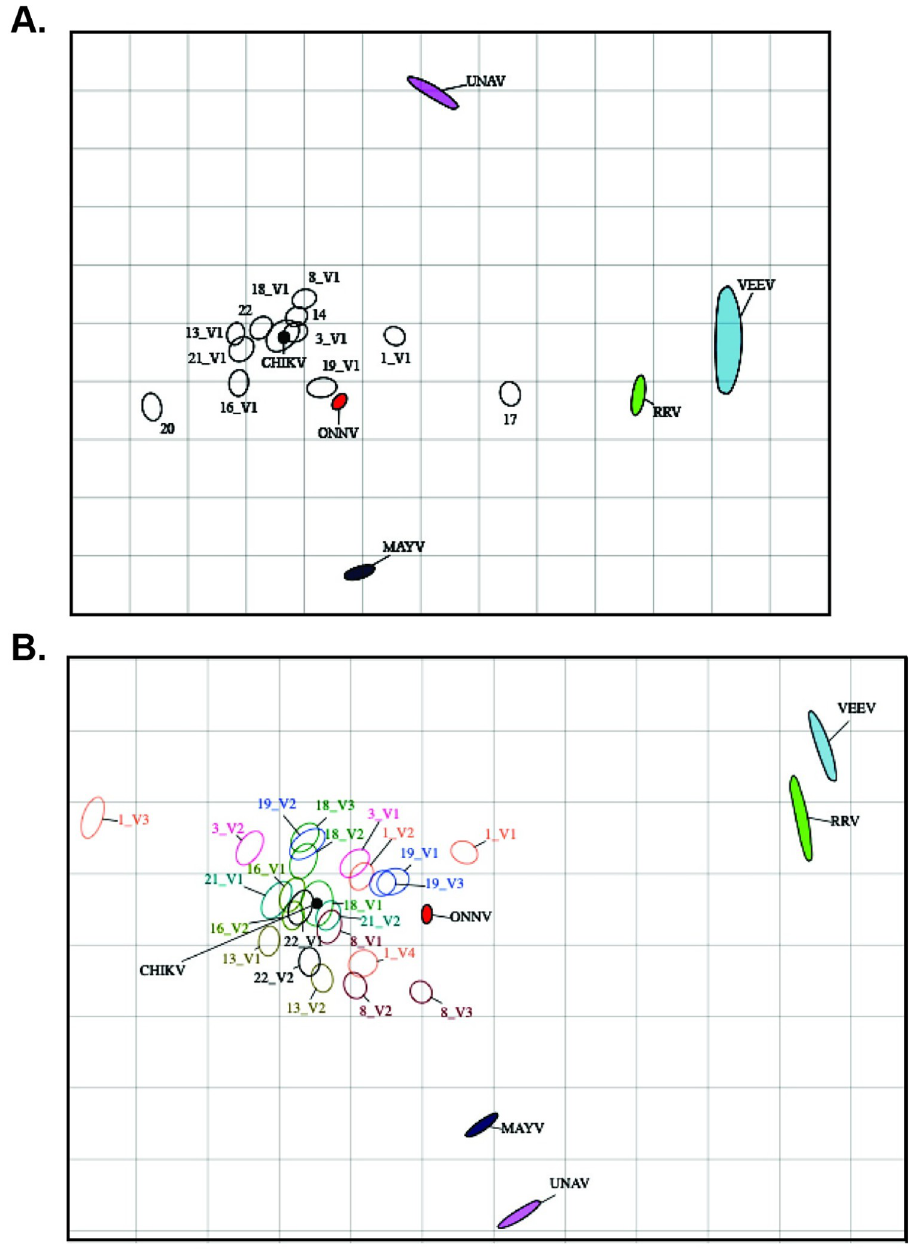
Fig 2. Antigenic cartography to map human subject alphavirus cross-neutralization by human sera. Antigenic map shows the relative antigenic relatedness between CHIKV, ONNV, RRV, MAYV, UNAV, and VEEV. Each unit of antigenic distance (AU), the length of one side of a grid square, is equivalent to a two-fold dilution in a neutralization assay. Sera are shown as open ellipses and labeled by subject number. Each virus is shown as a color filled ellipses and is colored according to virus strain (Fig 1A). The size and shape of each ellipse is the confidence area of its position. In making the map, each sera is initially plotted on top of the virus it most potently neutralizes and then pairwise distances between each sera:virus combination are calculated as a fold-difference in titer between the most potently neutralized virus and each other virus. The map is then optimized to place each virus relative to the serum samples in a manner that minimizes error between pairwise fold-differences. The closer a virus is to another virus, the more antigenically related the two are. Sera are initially plotted nearest to the virus they most potently neutralize with subsequently increasing distance to other viruses in descending neutralization potency against each virus. The antigenic map in (A) reflects each human subject at the primary blood draw, and (B) is representative of longitudinal